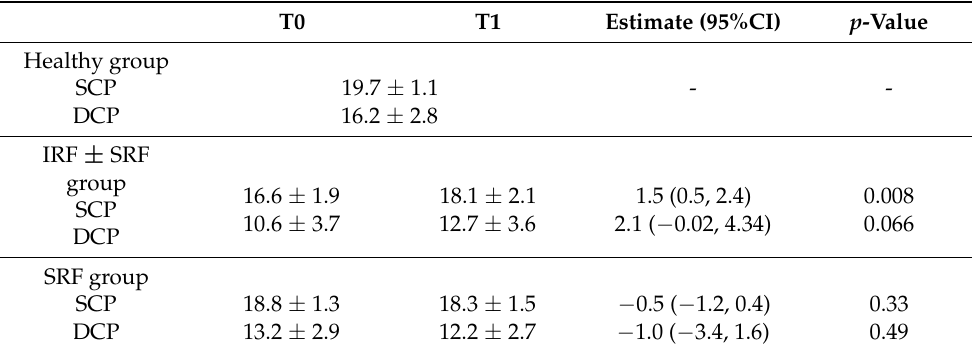
Table 7. Effect of time on mean vascular density (MVD) according to the patient group and plexus analyzed. The analyses were performed using a multivariable linear mixed effects model including age, fibrosis and atrophy as covariates. The estimate gives the increase or decrease in the variable between T0 and T1 independently of age, fibrosis and atrophy. T0 T1 Estimate (95%CI) p